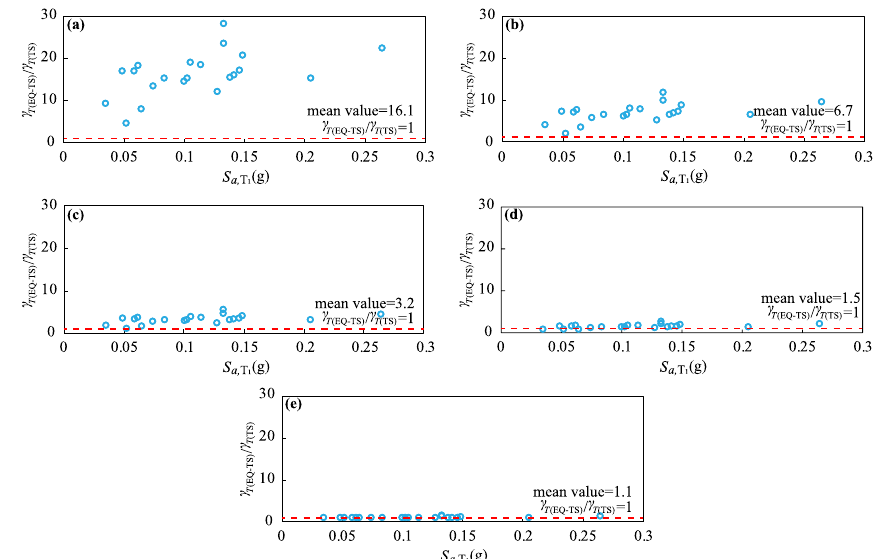
Fig. 12 Ratio of longitudinal pier drift with respect to the S a , T 7 m, d 8 m and e 9